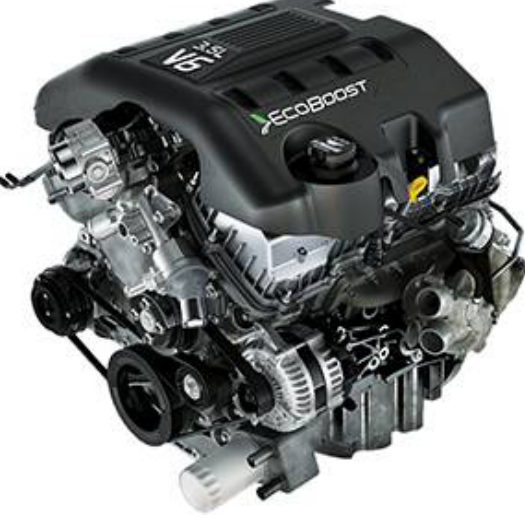
Figure 12. Ford 3.5 L EcoBoost Twin-Turbocharged V6 Engine [64].